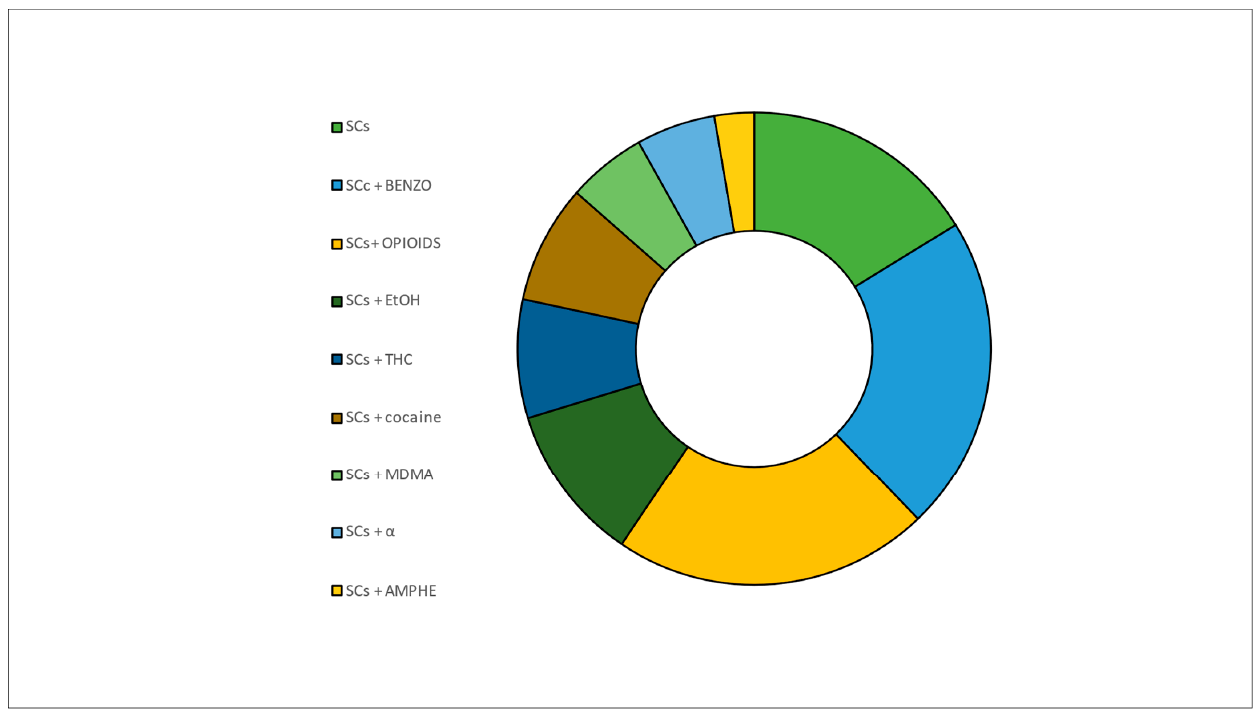
Figure 5. Association between SCs and other drugs in intoxication cases.